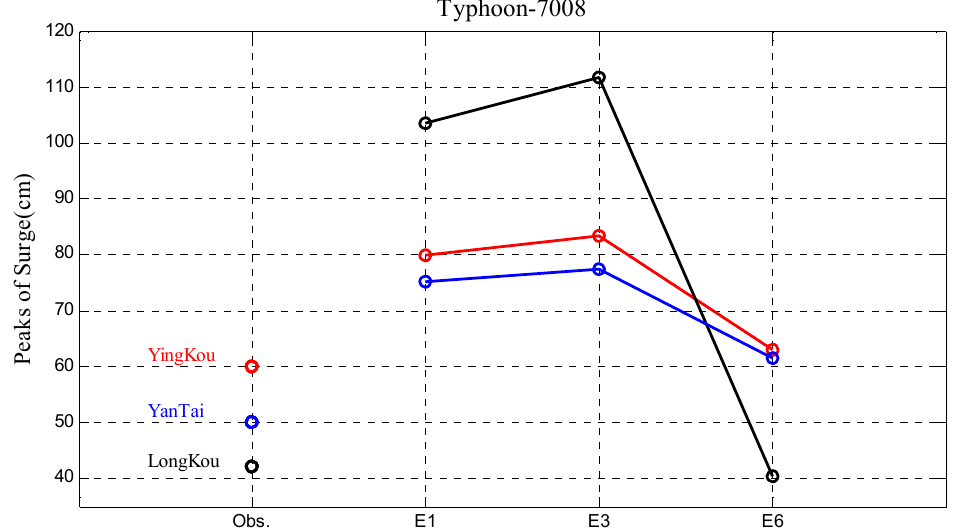
Figure 7. Storm surge elevations in six experiments (E1–E6), observations (black line) ( top ), and the method was superior to the drag coefficient formulas. differences between them ( bottom ) during Typhoon 7008 at YanTai station.